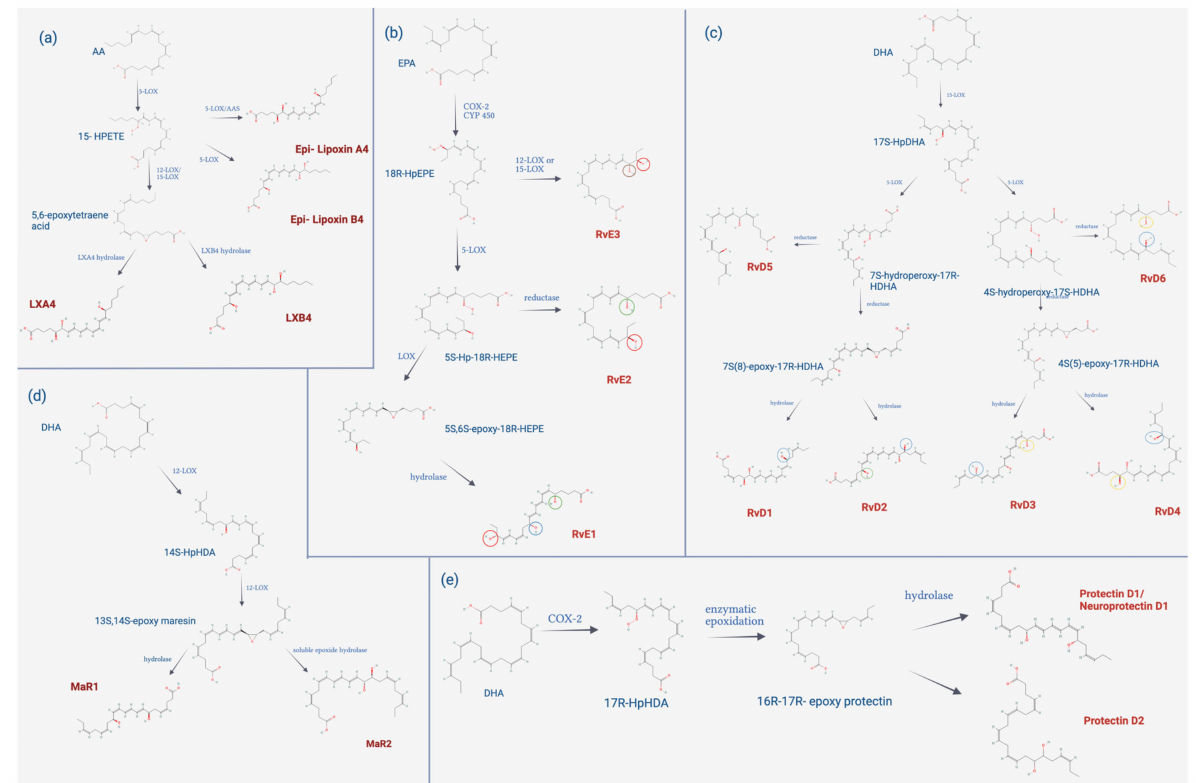
Figure 4. Biosynthesis of SPMs. ( a ) Lipoxin biosynthesis. The precursor of lipoxins is arachidonic acid (AA), which gives rise to lipoxin A4 (LXA4) and lipoxin B4 (LXB4), which are positional isomers, and epi-lipoxin A4 and epi-lipoxin B4, which are more stable than the former. ( b ) Biosynthesis of E-series resolvins (RvE). The precursor of RvE is acid eicosapentaenoic acid (EPA) of 20 carbons. Resolvin E1 (RvE1), resolvin E2 (RvE2), and resolvin E3 (RvE3) are similar in the presence of a hydroxyl group (OH) at carbon 18 (C18) (red circle). RvE1 and RvE2, unlike RvE3, present an OH group at C5 position (green circle). In addition, RvE1 has a third OH group at the C12 position (blue circle). Finally, RvE3 has an OH group in position C17 (brown circle). ( c ) Biosynthesis of D-series resolvins (RvD) RvD originates from the 22-carbon docosahexaenoic acid (DHA). All D-series resolvins have a hydroxyl group (OH) at the C17 position (blue circle). RvD1, RvD2, and RvD5 are generated from the oxygenation of 17S-hydroperoxy-docosahexaenoic acid (17S-HpDHA) in position C7; therefore, these resolvins have in common OH group in the said position (green circle). RvD1 and RvD2, unlike RvD5, are characterized by having a third OH group; RvD1 contains the OH group at the C8 position, while RvD2 has it at the C16 position. On the other hand, RvD3, RvD4, and RvD6 originate from the oxygenation of 17S-HpDHA at the C4 position, therefore these resolvins have a common OH group at that position (yellow circle). RvD3 has a third OH group in the C11 position, while RvD4 has the third OH group in the C5 position. ( d ) Biosynthesis of maresins. The precursor of maresins is DHA originating from two exponents, MaR1 and MaR2. ( e ) Protectin biosynthesis. The precursor of protectins is DHA and originates through enzymatic epoxidation and subsequent hydrolysis of PD1 (created with BioRender.com, accessed on 9 September